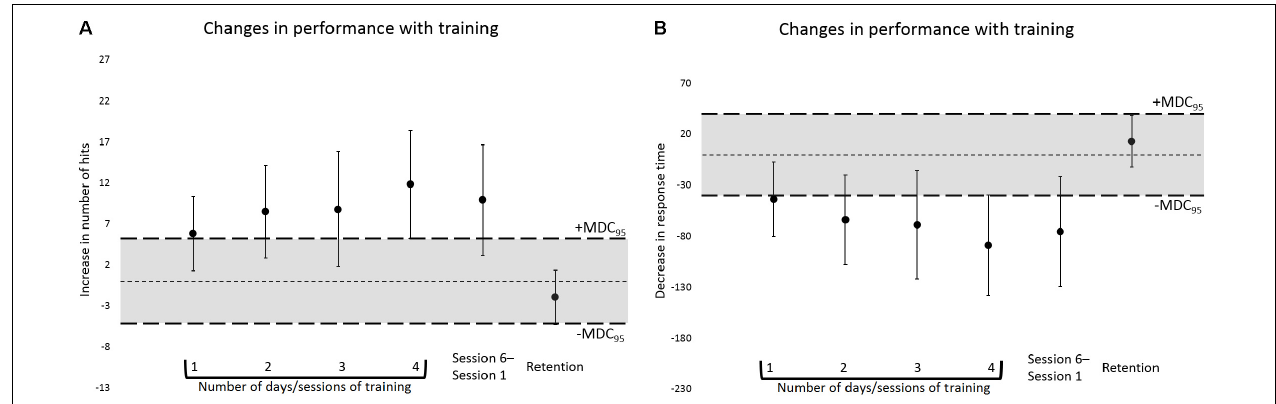
FIGURE 4 | Changes in performance, in terms of number of hits (A) and RT (B) , as a function of the number of days/sessions of training on the task. From left to right: Means of the differences in performance between Sessions 1 and 2, 1 and 3, 1 and 4, 1 and 5, 1 and 6, and 5 and 6. The thin dashed horizontal lines indicate a mean difference of 0. The thick dashed horizontal lines indicate the ± MDC 95 values ( ± 5.21 for number of hits and ± 39.97 ms for RT). The shaded areas between the ± MDC 95 values represent the interval corresponding to the range of random measurement error. Changes in performance that are within this interval, irrespectively of statistical significance, are likely to result mostly from random measurement error, as opposed to from real modifications in performance, e.g., from learning. Group data are displayed. Error bars = 95%